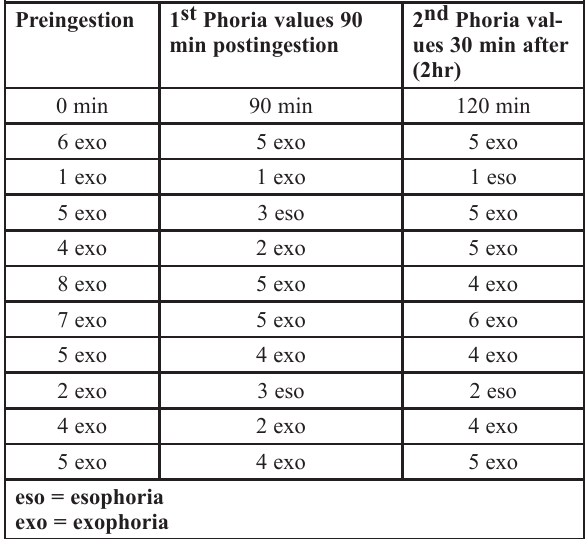
Table 2: Changes in habitual phoria at near following acute ingestion of 30g Cola